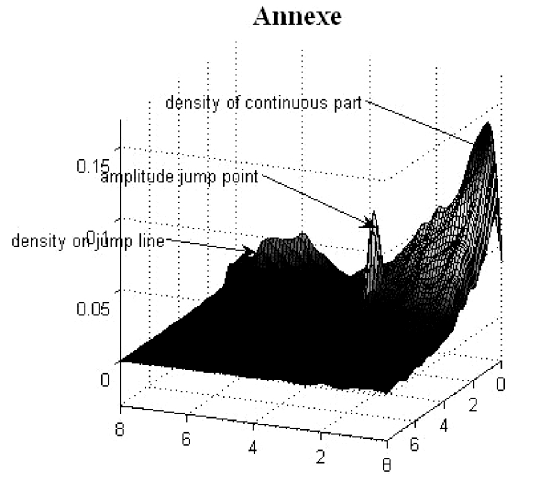
Figure 1 – The kernel density of bivariate random variable ( X , Y ).